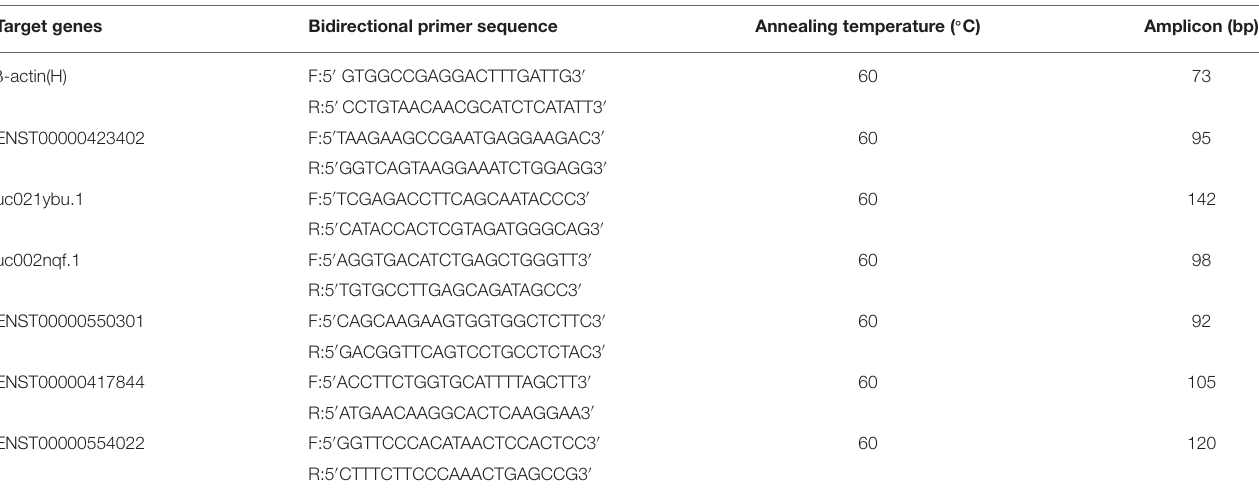
TABLE 2 | The primers for RT-qPCR.